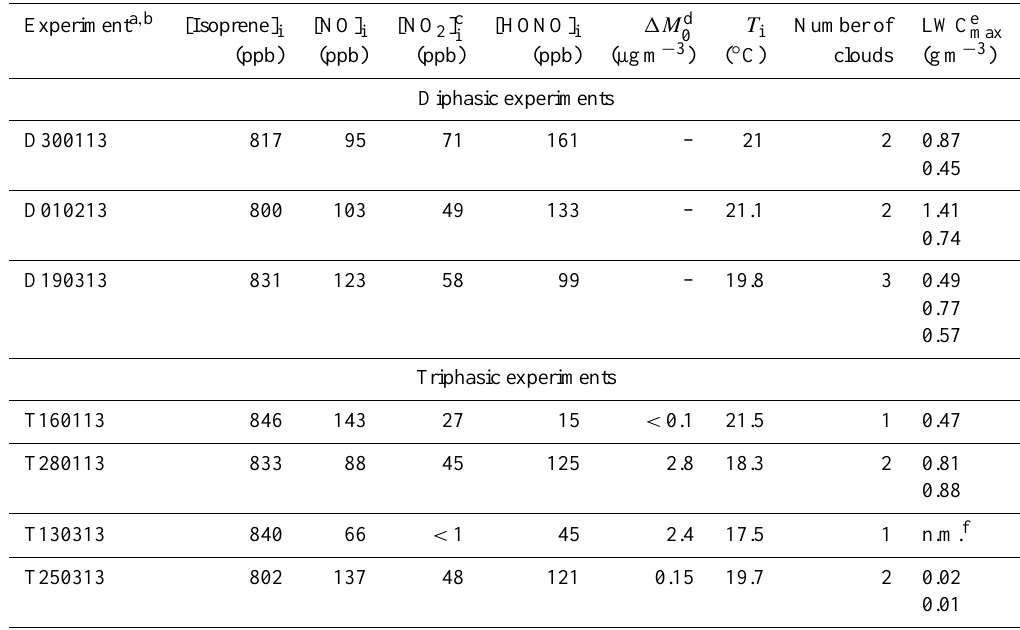
Table 2. Initial experimental conditions, maximum aerosol mass obtained under dry conditions and information on the generated clouds. Experiment a ,